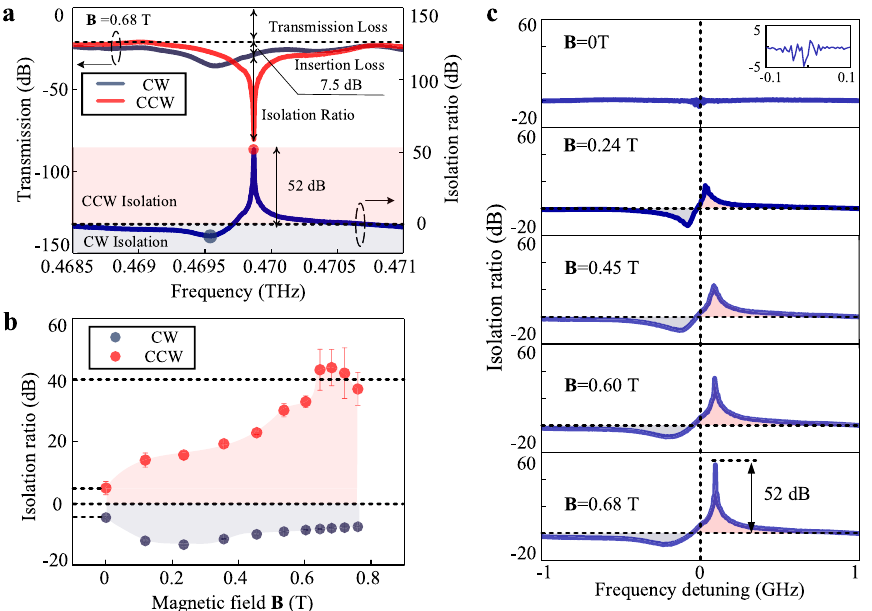
Fig. 3 Performance characterization of the terahertz isolator. a Transmission spectra of the chip when B = 0.68 T, and the isolation ratios are de fi ned as H – H CW CCW ; the positive isolation ratio indicates that the loss in CW direction is smaller while the negative isolation ratio refers to the larger loss in CW direction. b Measured maximum isolation ratios of positive and negative states with the change of the magnetic fi eld. The error bars represent the standard deviations of three measurements of isolation ratios. c Isolation spectra of the chip in the change of the magnetic fi